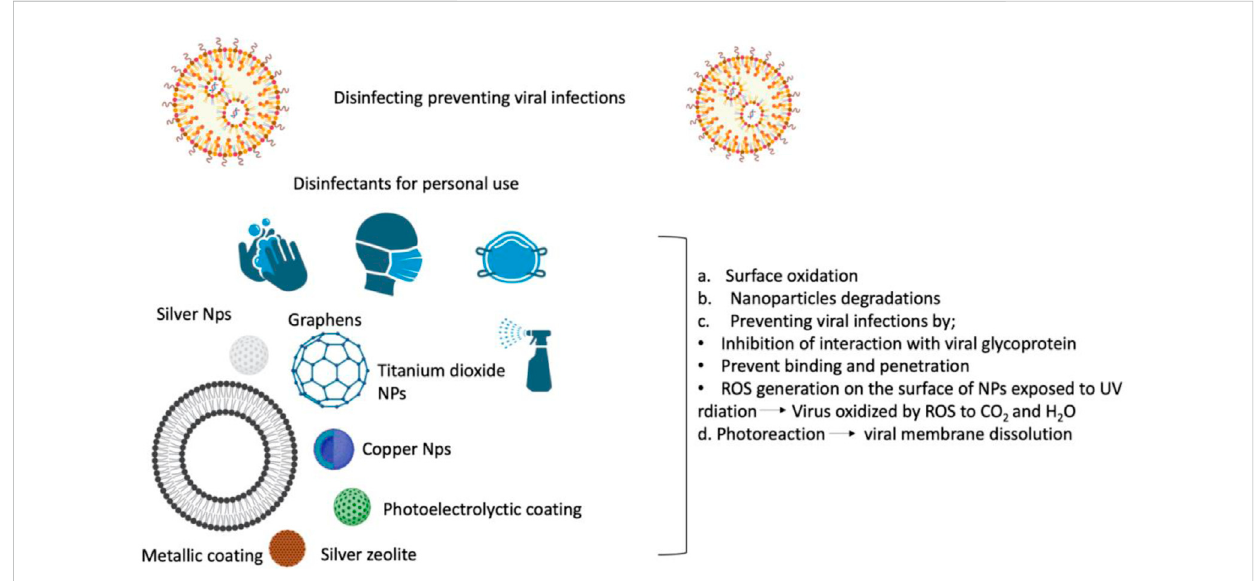
FIGURE 2 Viral disinfectants based on nanotechnology protect against SARS-CoV-2 by preventing viral propagation on surfaces, in the air, and in safety equipment.